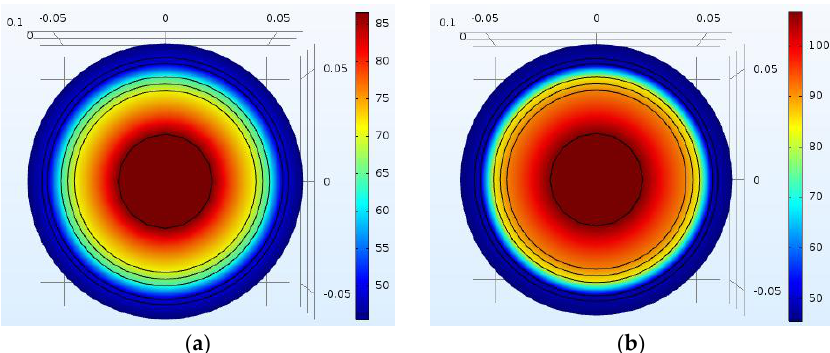
Figure 12. Steady temperature distributions by FEM simulations based on Method 4 for Case 1: ( a ) Approach 1 and ( b ) Approach 2.